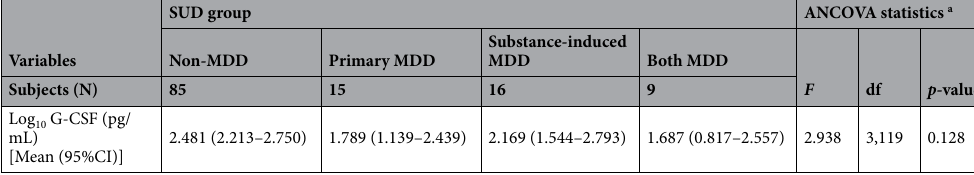
Table 5. Plasma concentrations of G-CSF and type of comorbid MDD in the SUD group. a Data were analyzed using ANCOVA (type of MDD, sex, age).